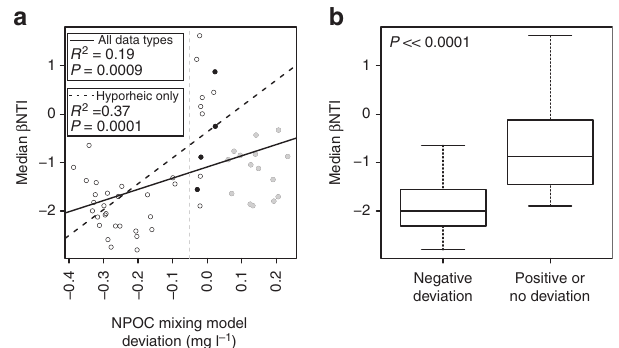
Figure 6 | Relationships between b NTI and mixing model deviations. ( a ) b NTI estimate of each community as a function of the deviation between observed and expected NPOC; the solid line indicates the regression model and statistics are provided; open, closed black and closed grey symbols indicate hyporheic, river and ground water samples, respectively. (b ) Box plots summarizing distributions of median b NTI values—from a —that are or are not associated with a negative NPOC deviation; b NTI values included in the ‘negative deviation’ distribution are to the left of the dashed grey line in a and all other b NTI values are included in the ‘positive or no deviation’ distribution; the displayed P -value indicates a significant difference between distributions by a Kruskal–Wallis test.